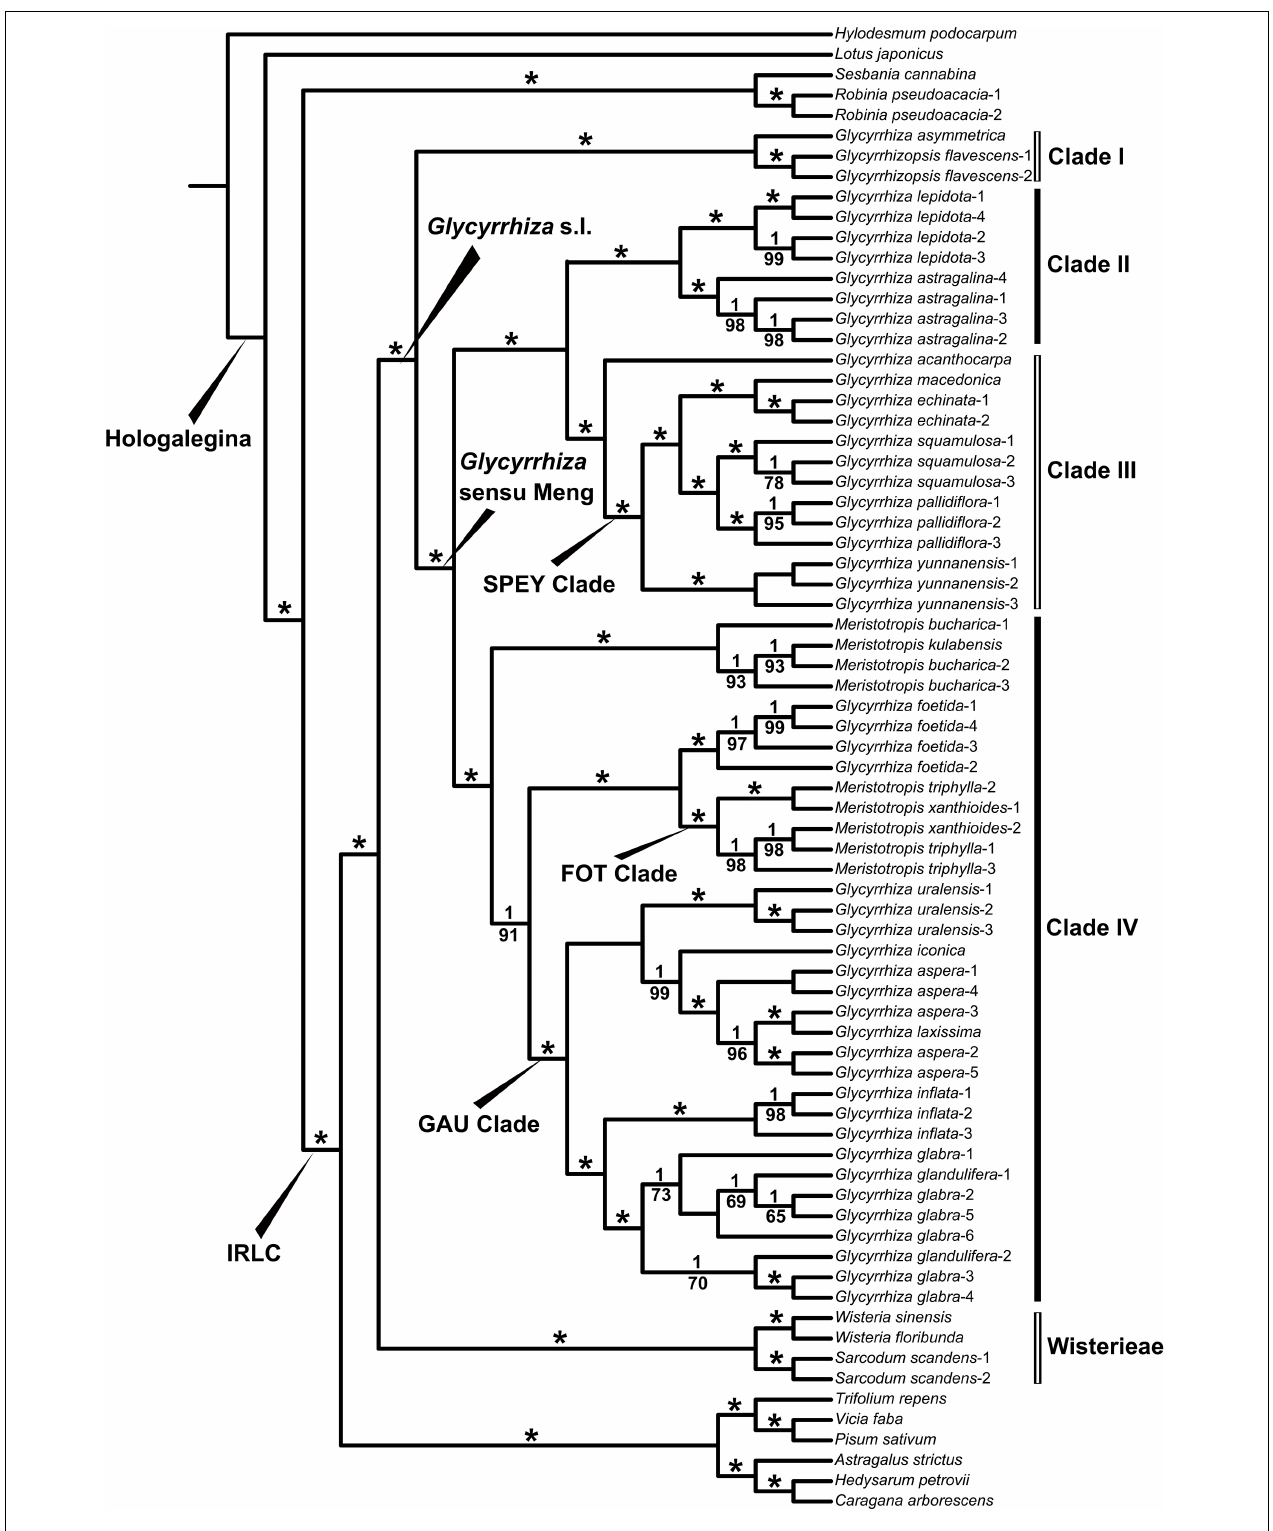
FIGURE 1 | Maximum clade credibility tree resulting from Bayesian Inference of Glycyrrhiza s.l. based on whole chloroplast genome sequences. Bayesian posterior probabilities ( PP ≥ 0.95) are given above branches, maximum likelihood bootstrap values (LBS ≥ 50%) below branches. Asterisks indicate both of PP = 1 and LBS = 100%. The Hologalegina and IRLC clades were labeled following Wojciechowski et al. (2004).